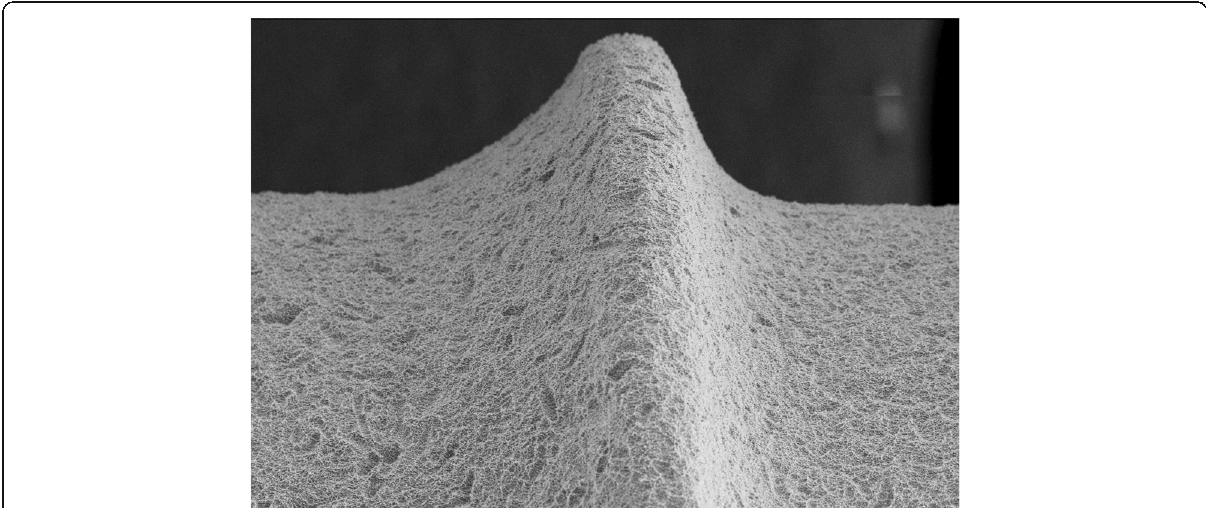
Fig. 1 Scanning electron microscopy picture of group A implant